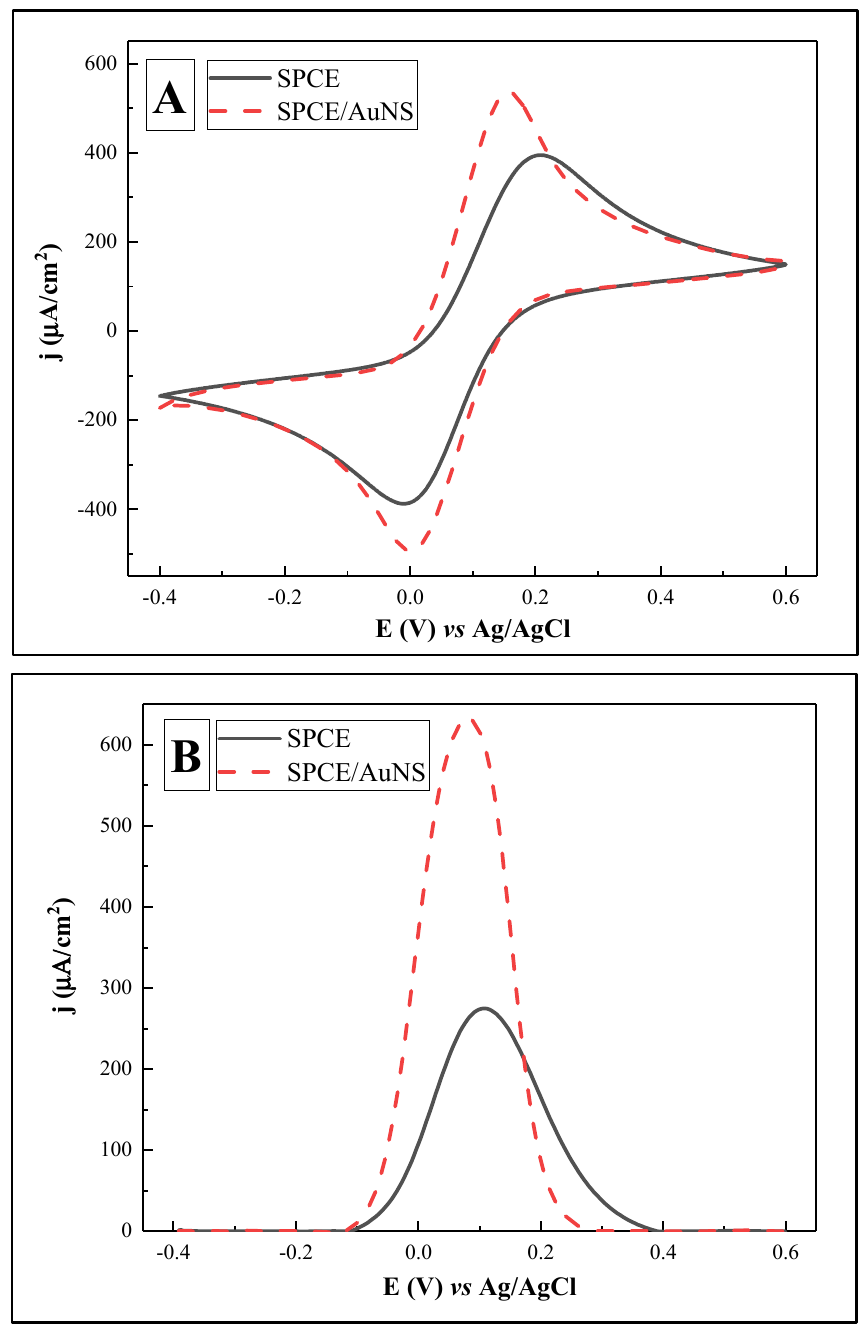
Figure 2. Cyclic voltammograms ( A ) and differential pulse voltammograms ( B ) for SPCE (—) and SPCE/AuNS (- - -). Potential range was from − 0.4 to +0.6 V, with a CV scan rate of 0.05 V/s, DPV step size of 0.004 V, pulse height of 0.05 V, pulse period of 100 ms, and pulse width of 50 ms, in 10 mM PBS, pH 7.4, containing 2 mM [Fe(CN 6 )] 3 − /4 − . Signal normalized to the geometrical area of the working electrode (0.126 cm 2 ).